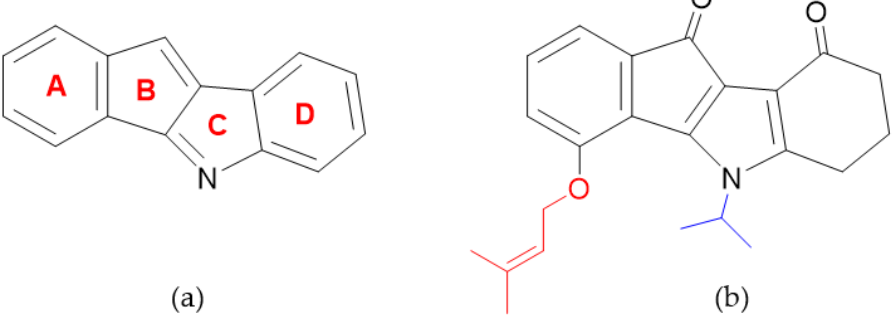
Figure 1. Structure of indeno[1,2- b ]indole scaffold with the corresponding labels of the aromatic four-ring system ( a ) and 4p ( b ) with both substitutions important for strong CK2 inhibition (i.e., prenyloxy and isopropyl groups) shown in red and blue, respectively.